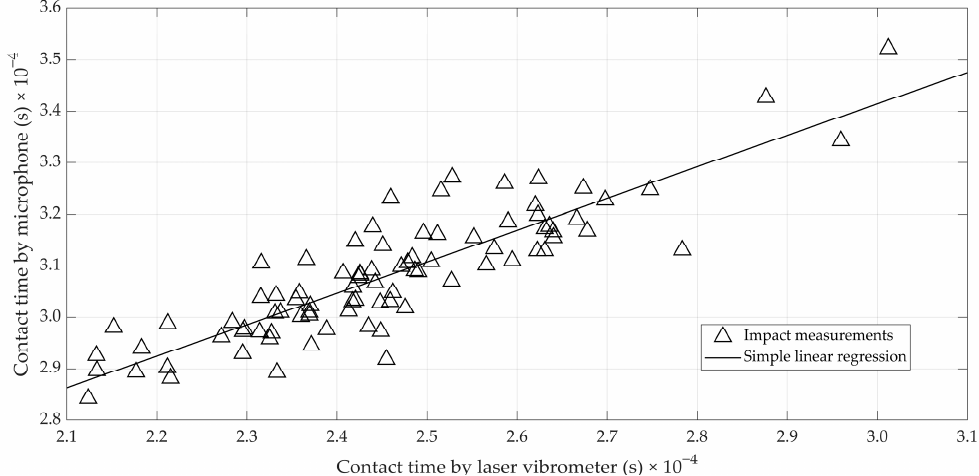
Figure 3. Scatterplot illustrating the relation between the reference contact time as measured by the laser vibrometer, and the contact time derived from the microphone signal.